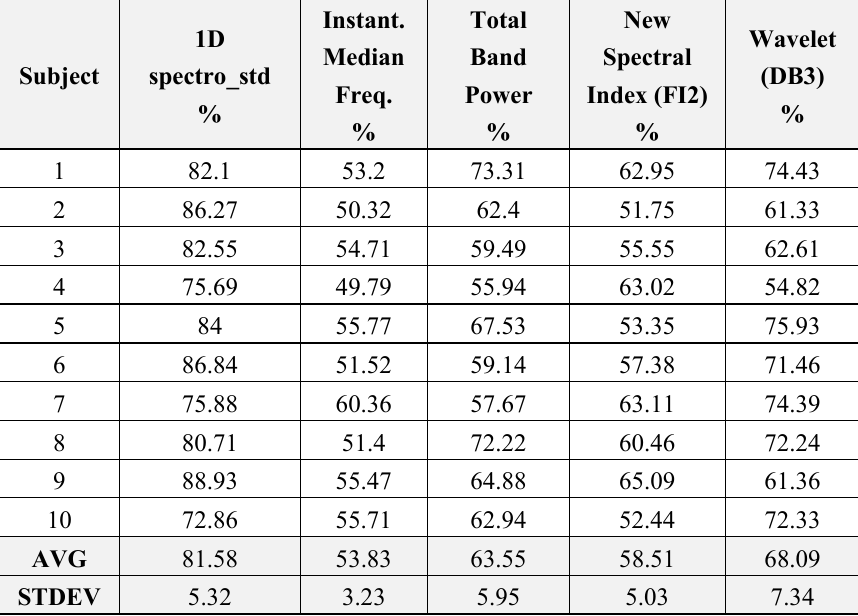
Table 3. Percent correct classification for Non-Fatigue and Transition-to-Fatigue for the various features within subjects.